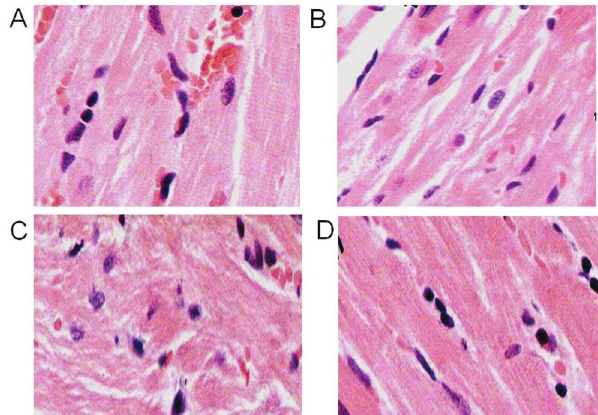
Figure 2 - In the IH group (A), cardiomyocyte nuclei were found to be smaller and have a lower volume than the nuclei in other groups. Cardiomyocytes in the CON group (B) had normal cardiomyocyte nuclear size without evidence of any type of cellular injury. In the IHM group (C) decreased cardiomyocyte nuclear volume was observed, but the nuclei were larger than those of car- diomyocytes in the IH group. In the MEM group, (D) we observed increased cardiomyocyte nuclear size. The nuclei were normal in appearance without evidence any type of cellular injury (HE – Amplification 400